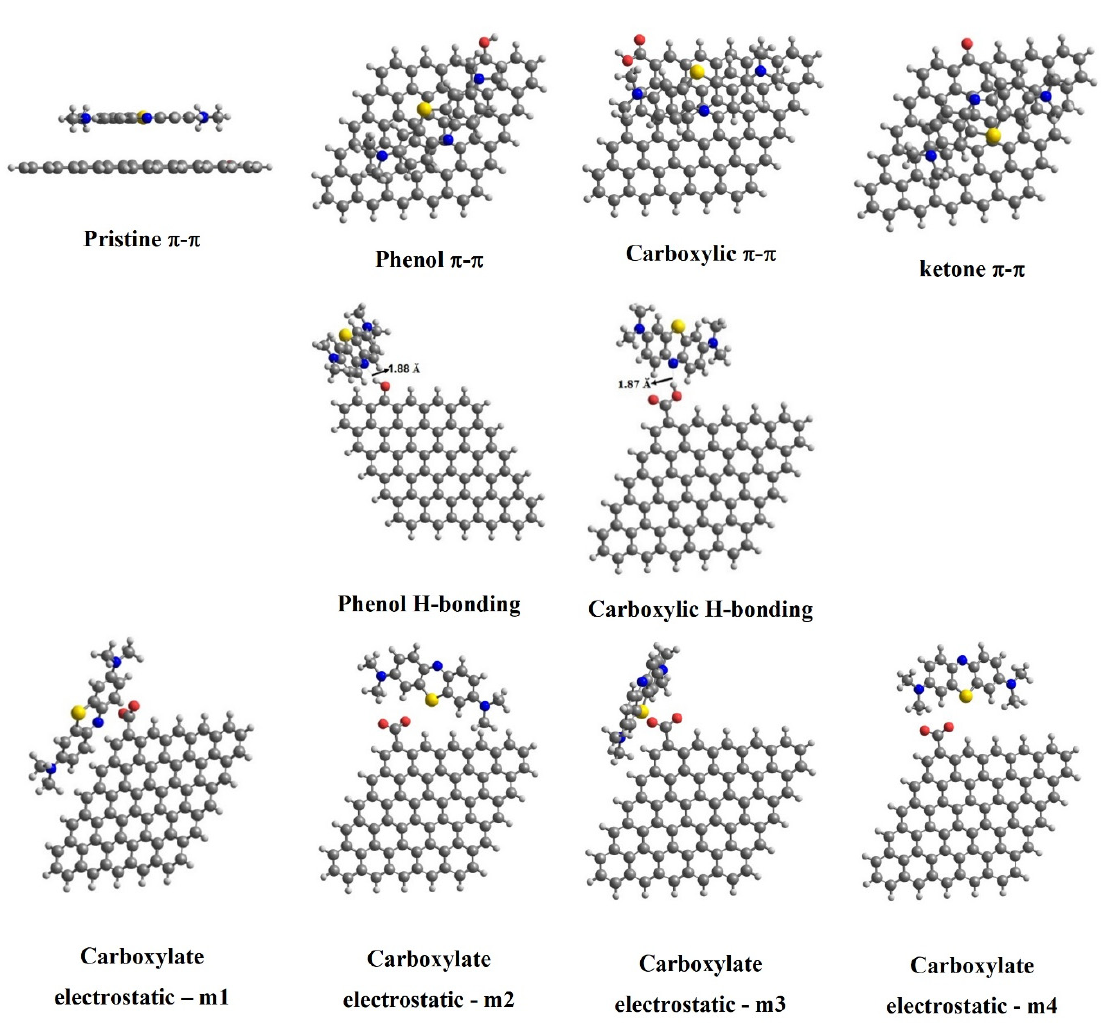
Figure 7. The optimized structures of MB + adsorption on oxygenated and pristine carbon surfaces. Table 4. Adsorption energy values (kcal mol − 1 ) for the interactions between methylene blue with a pristine carbon surface and different oxygen functional groups. (The total energy (Hartree) of all systems are presented in the Table